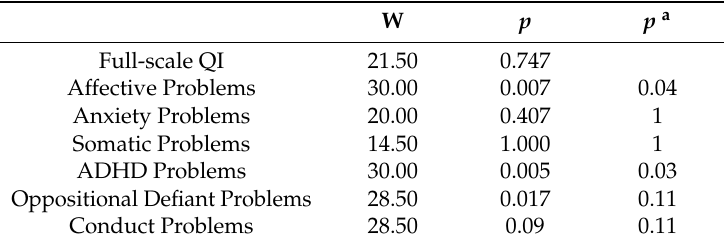
Table 1. Group comparison for estimated IQ, age and parent-rated Child Behavior Checklist (CBCL) T-scores.